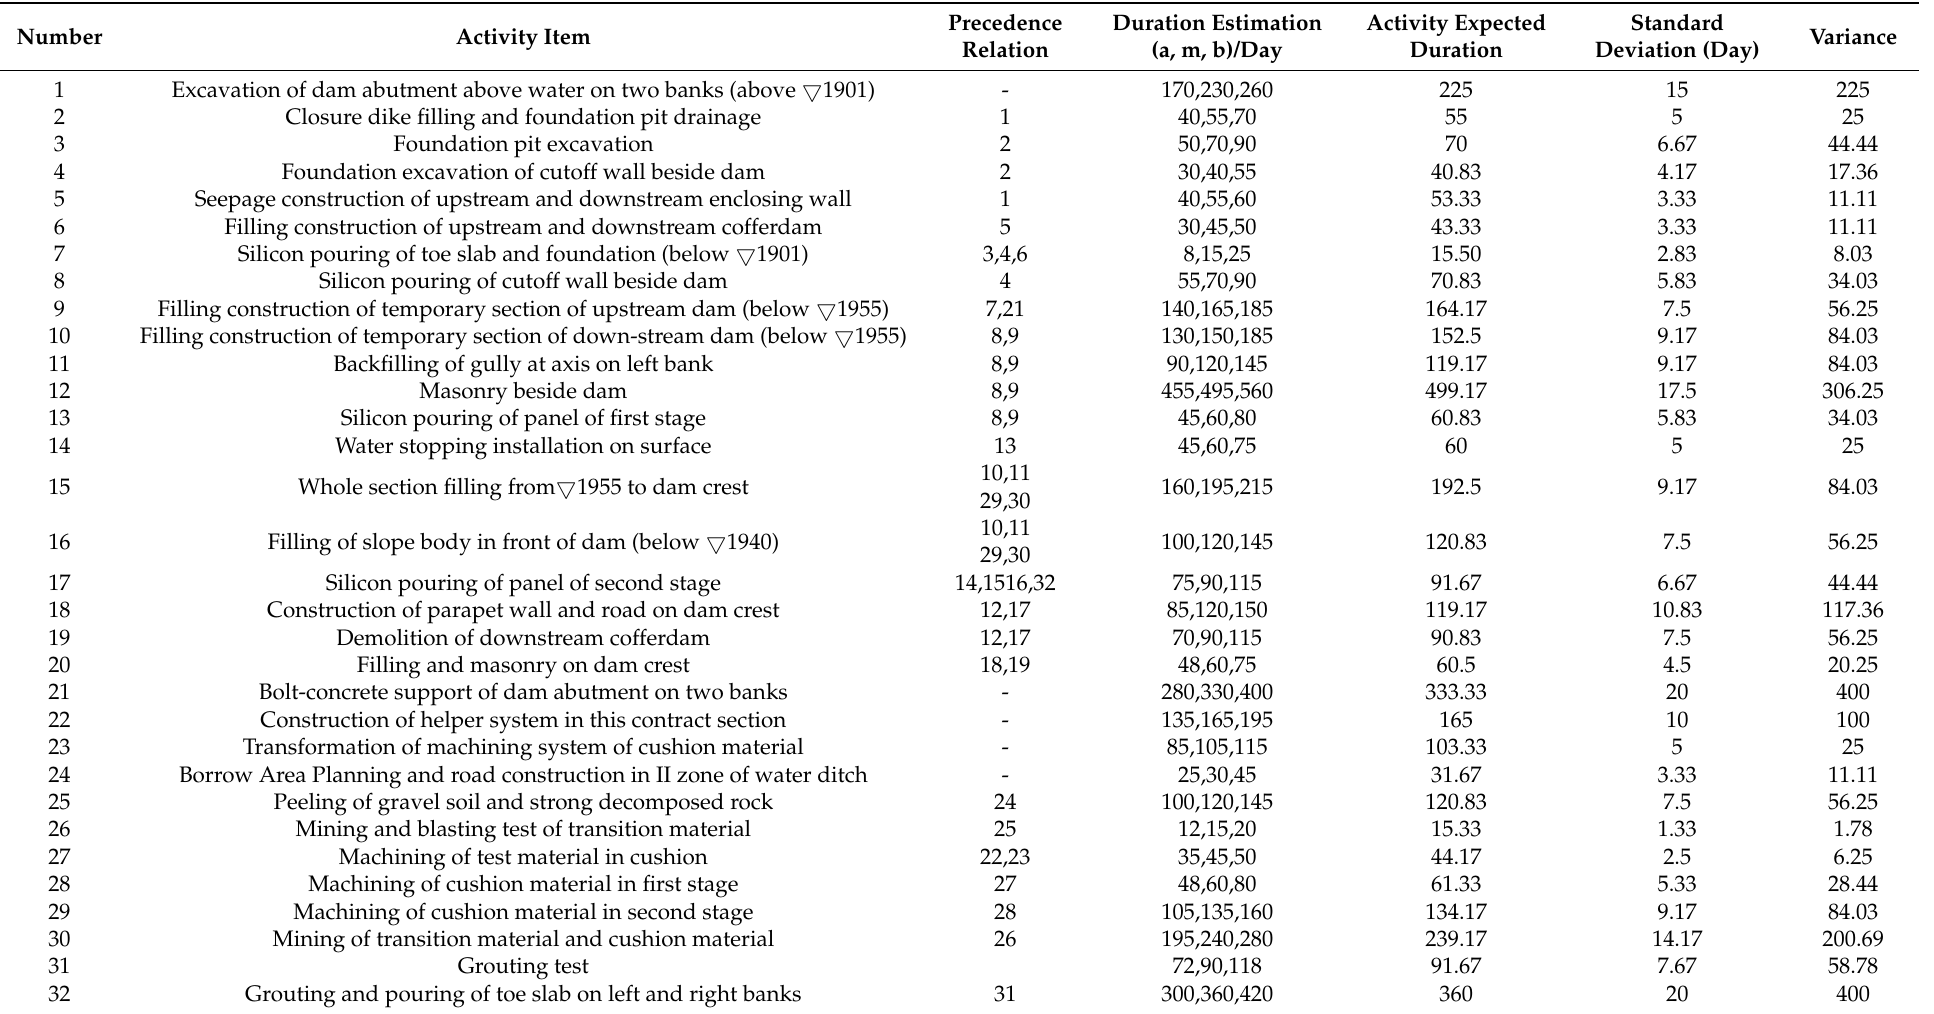
Table 1. Detail table of engineering construction process